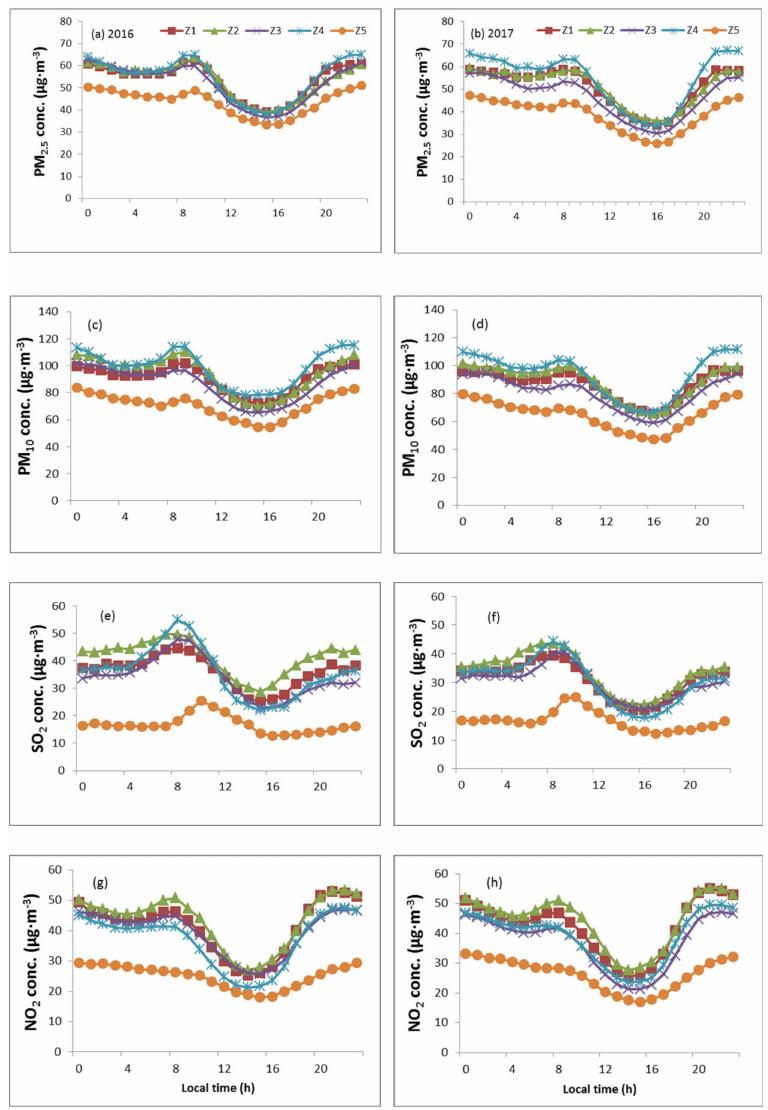
Figure 2. Average hourly concentrations of ( a ) PM 2.5 in 2016, ( b ) PM 2.5 in 2017, ( c ) PM 10 in 2016, ( d ) PM 10 in 2017, ( e ) SO 2 in 2016, ( f ) SO 2 in 2017, ( g ) NO 2 in 2016, and ( h ) NO 2 in 2017 in five ecological functional zones in